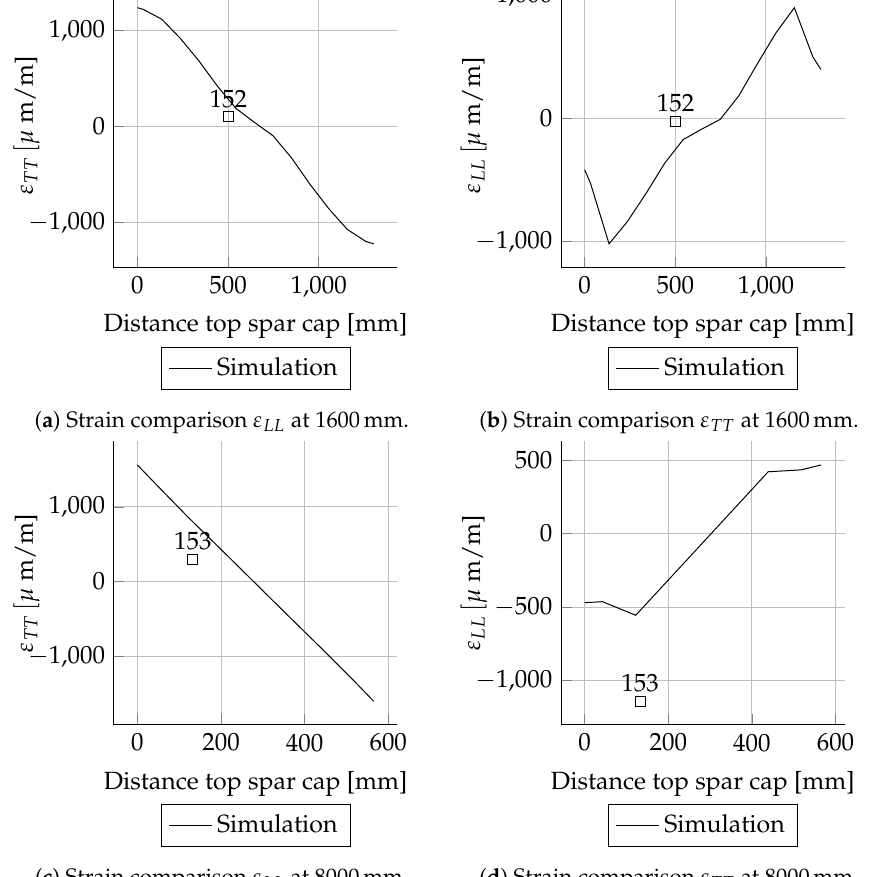
( c ) Strain comparison ε LL at 8000mm. ( d ) Strain comparison ε TT at 8000mm. Figure A52. Cont